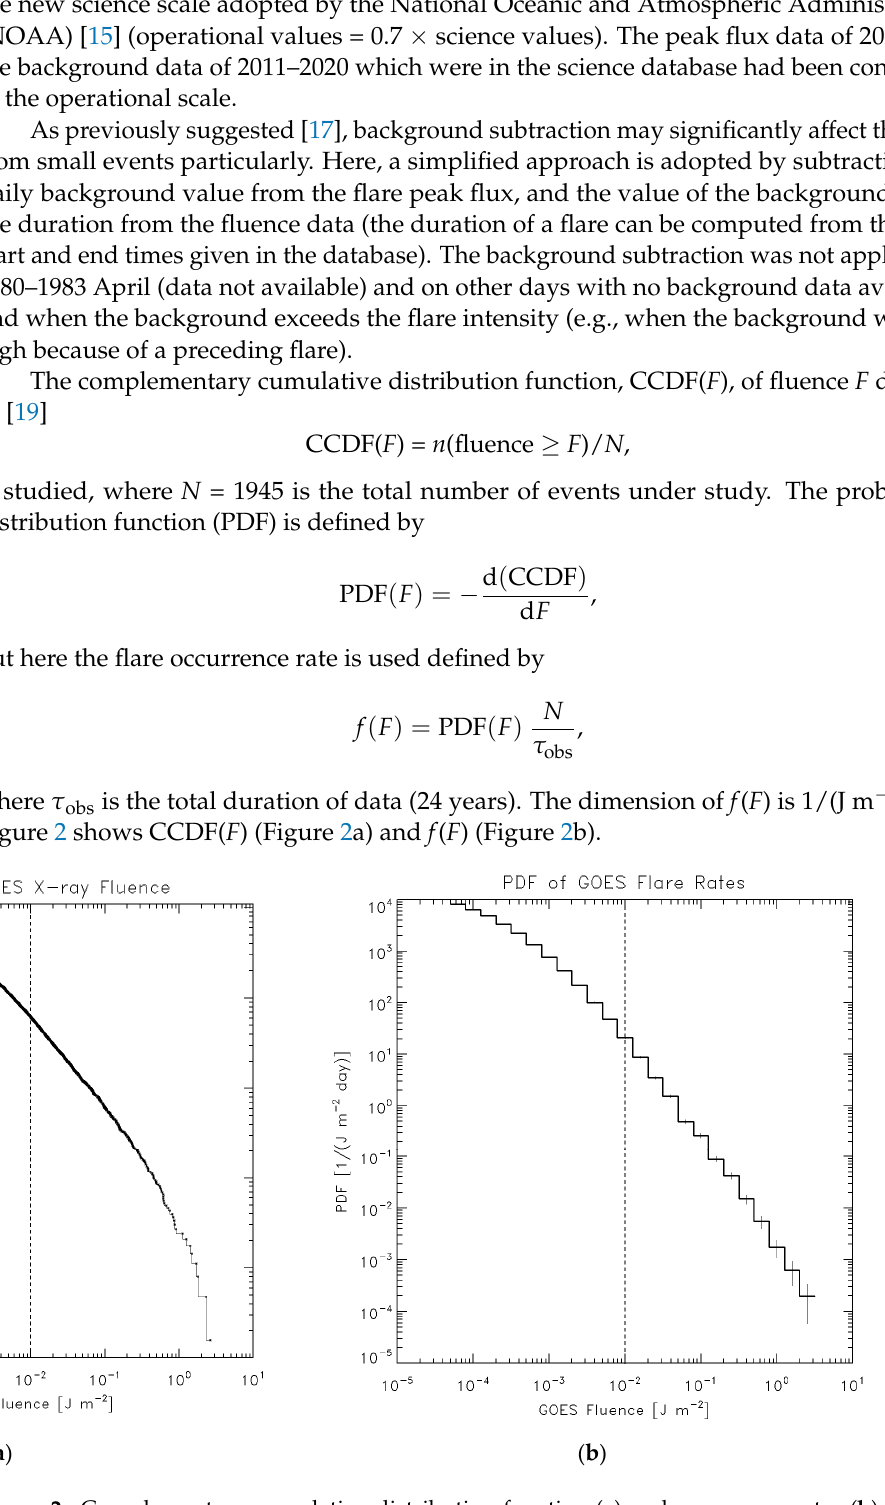
Figure 2. Complementary cumulative distribution function ( a ) and occurrence rates ( b ) of flare fluence, F . The histogram in plot ( b ) is built with a bin-size of ∆ log 10 F = 0.2. Short vertical bars √ n on the bins with counts n indicate statistical errors of